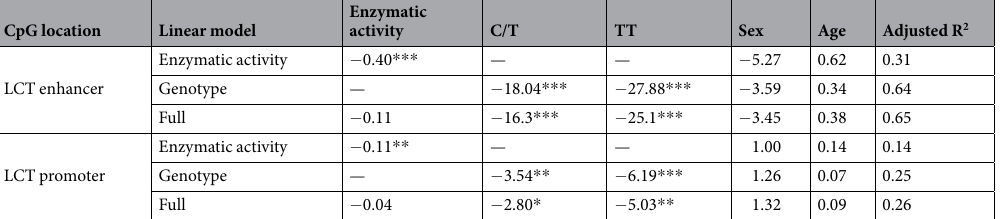
Table 2. Linear regression analysis of pyrosequencing measurements, LPH enzymatic activity and/or the − 13910C > T genotype. Asterisks indicate significance of coefficients (p < 0.1, * p < 0.05, ** p < 0.01, *** p < 0.001). The table shows the predictive power of DNA methylation for all − 13910C > T genotypes. The coefficients for C/T and TT are reported with respect to the CC genotype. Negative coefficients indicate lower methylation levels for the C/T and TT genotype compared to the CC genotype.